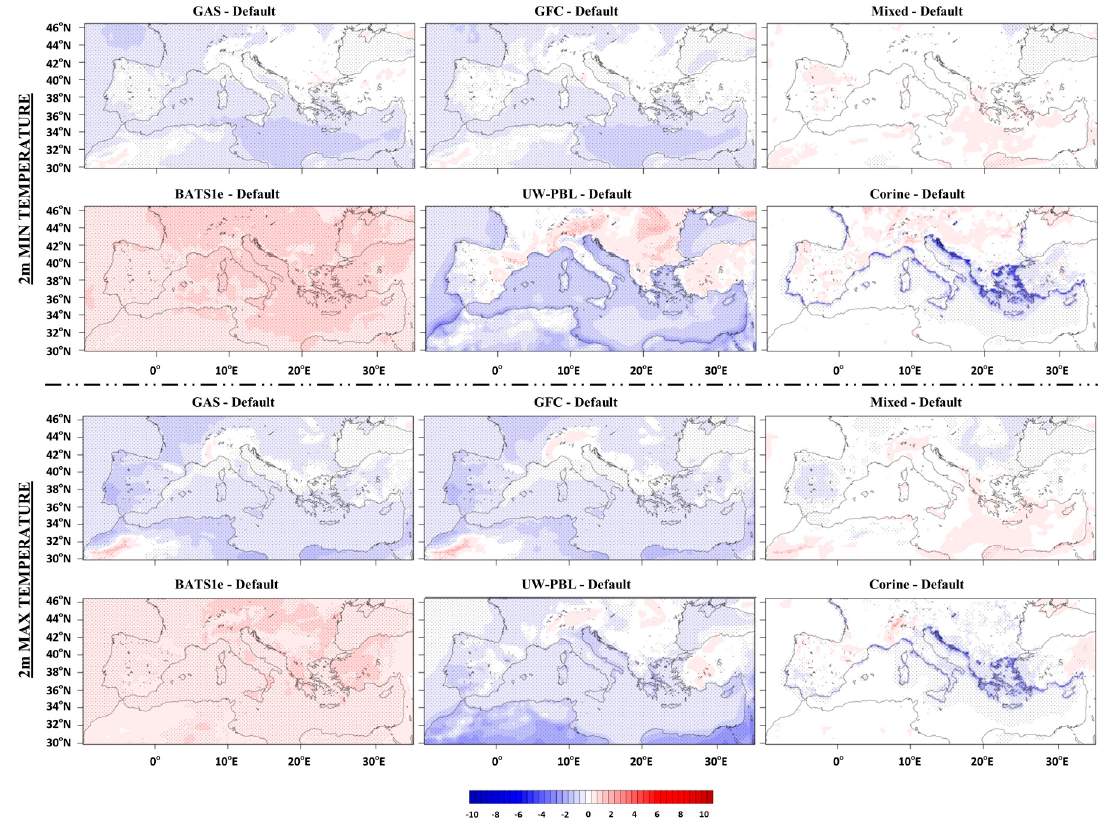
Figure 7. Differences in near surface (2 m) min and max temperature from the default simulation for the performed simulations during winter. The statistical significance of the differences in the maps is represented by the dotted